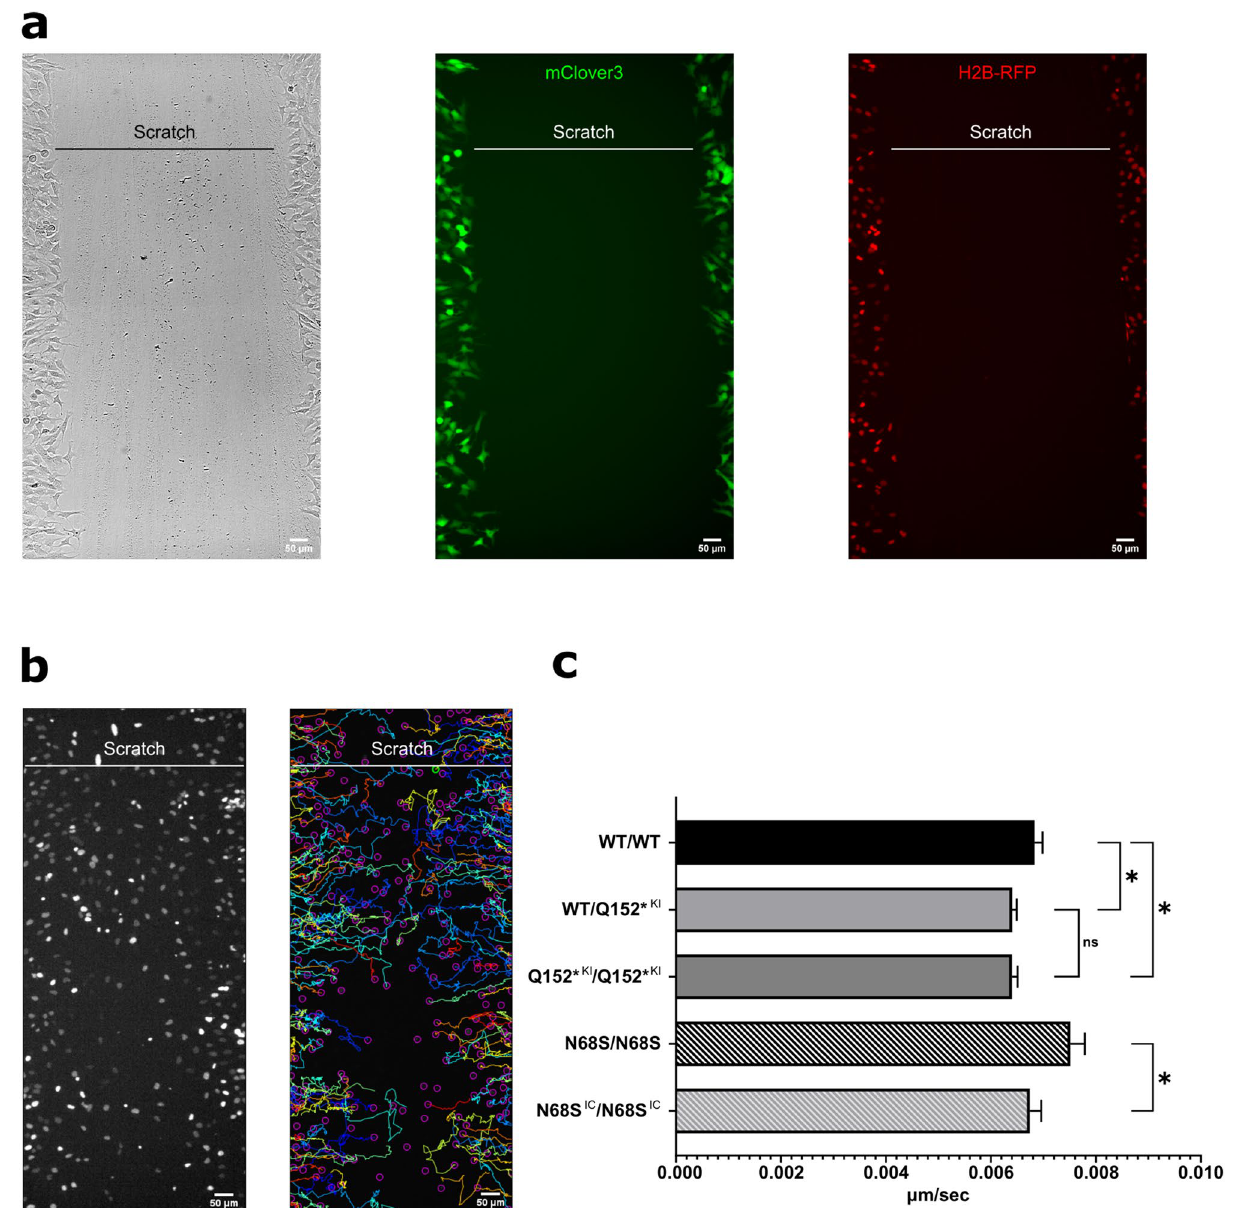
Figure 3. In vitro migration of iPSC derived wild type and mutant cranial neural crest cells. ( a ) Representative images of scratched area for BJ1 wild type derived CNCC to migrate into at 0 h. Cells have been transfected with mRNA 24 h prior to imaging. From left to right: Bright field, cytosolic free-floating mClover3 and nuclei labelled with H2B-mCherry. Scale bar is 50 μm. Also see Additional Movie Files 1, 2 and 3. ( b ) Left: image of the same scratched area in ( a ) after 24 h of migration visualizing labeled nuclei with H2B-mCherry. Right: Representative image of tracking the migration path of individual neural crest cells using ImageJ plugin TrackMate. ( c ) Quantification of the neural crest migration speed. Cells carrying either the heterozygous or the homozygous Q152* mutation (Q152* KI /WT, Q152* KI /Q152* KI ) displayed a lower migration speed compared to their isogenic control line WT/WT. No difference between the full knock down Q152* KI /Q152* KI of MAPRE2 compared to the heterozygous knock down Q152*KI/WT was noted (One-Way ANOVA, Tukey test, P = 0.045, P = 0.0423 and P = 0.9996, respectively). In contrast, the N68S/N68S mutant NC cells migrated faster than their respective isogenic control line N68S IC /N68S IC (Unpaired t-test, P = 0.044). N = 11 for each